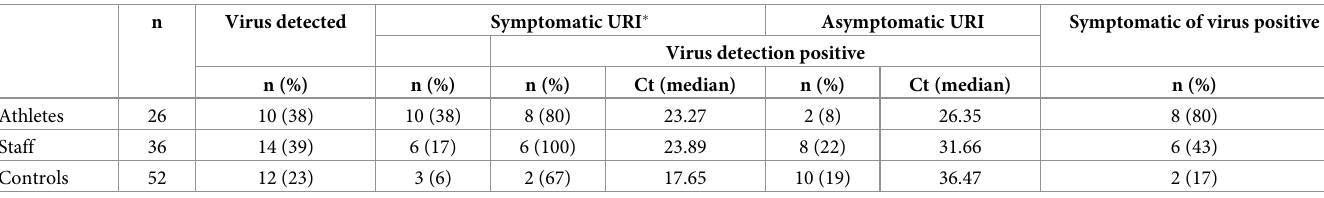
Table 2. Respiratory virus infections in team Finland and in controls in